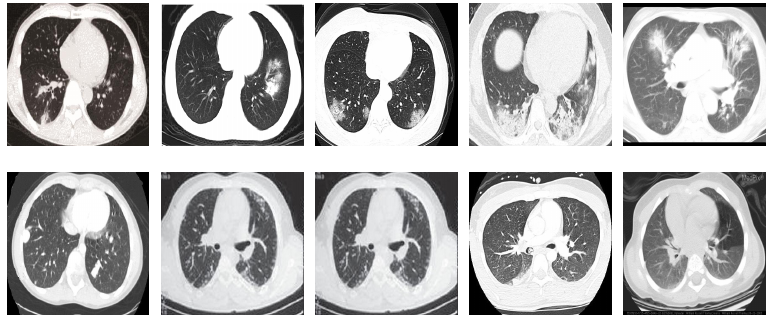
Figure 8. Examples of chest CT images from the COVID19-CT dataset. The first row represents CT images diagnosed with COVID-19, whereas the second row represents non-COVID-19 cases, but other lung